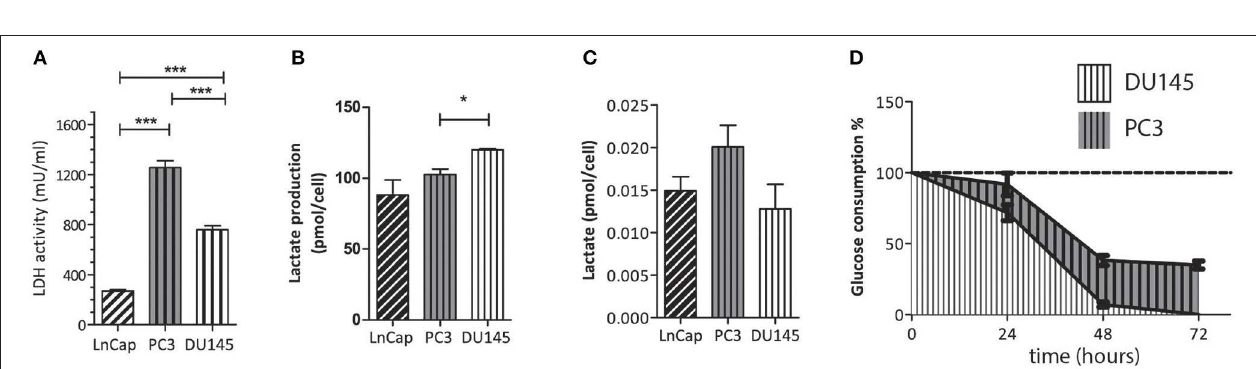
FIGURE 2 | Results on the biocompatibility of the aqueous solutions obtained from the PHIP-SAH procedure. All cell lines were treated with: (A) an aqueous solution of pyruvate obtained from the PHIP-SAH procedure; (B) an aqueous solution containing traces of chloroform and catalyst; (C) an aqueous solution containing chloroform traces; (D) an aqueous solution of allyl alcohol and (E) the aqueous solution of the product of the PHIP-SAH procedure, to which ethanol was added. The cells viability was assessed by MTT assay. Data are the mean + SD from three independent experiments ( n = 3). * P ≤ 0.05, *** P ≤ 0.001, ns: not significant vs. untreated control (100% viable); one-way